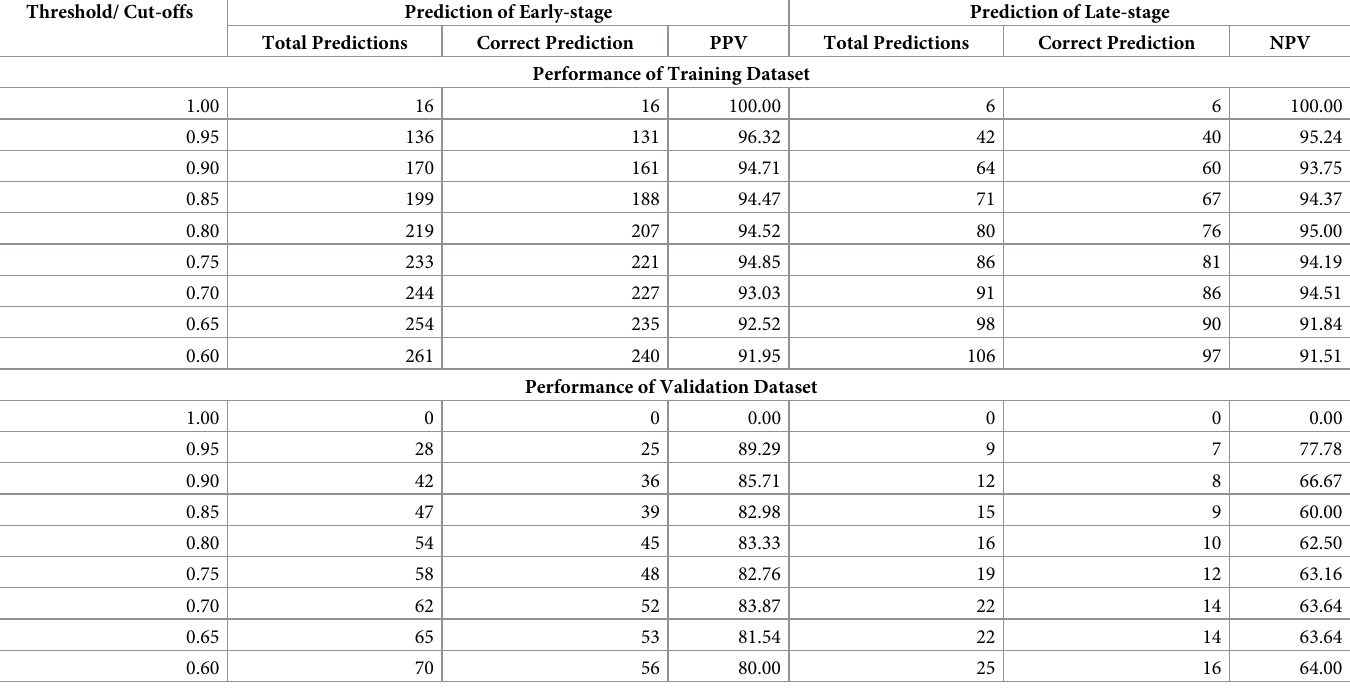
Further, we also calculated PPV and NPV on various thresholds of the SVC probability score (Table 3). On the training data, for the SVC score greater than 0.90, 161 early-stage sam- ples are correctly predicted out of a total of 170 samples predicted as early-stage samples (PPV = 94.71%). In the case of late-stage samples, 60 out of 64 late-stage predicted samples are correct (NPV = 93.75%). In the case of validation data, the PPV is 85.71%, and the NPV is Table 3. The performance of SVC based model at the different threshold in term of the probability of correct prediction, developed using 36-full feature set (THCA-EL-SVC-L1) on training and validation dataset. Threshold/